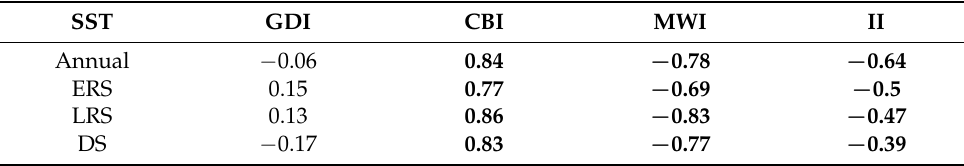
Table 7. Summary of regional sea-surface temperatures (SST) correlations with GDI (bold represents statistical significance at 95% test